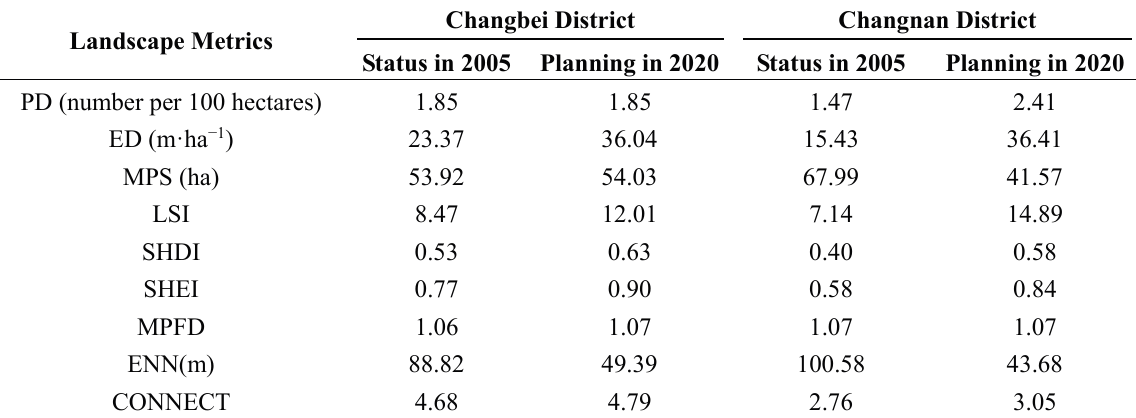
Table 2. Landscape metrics on landscape